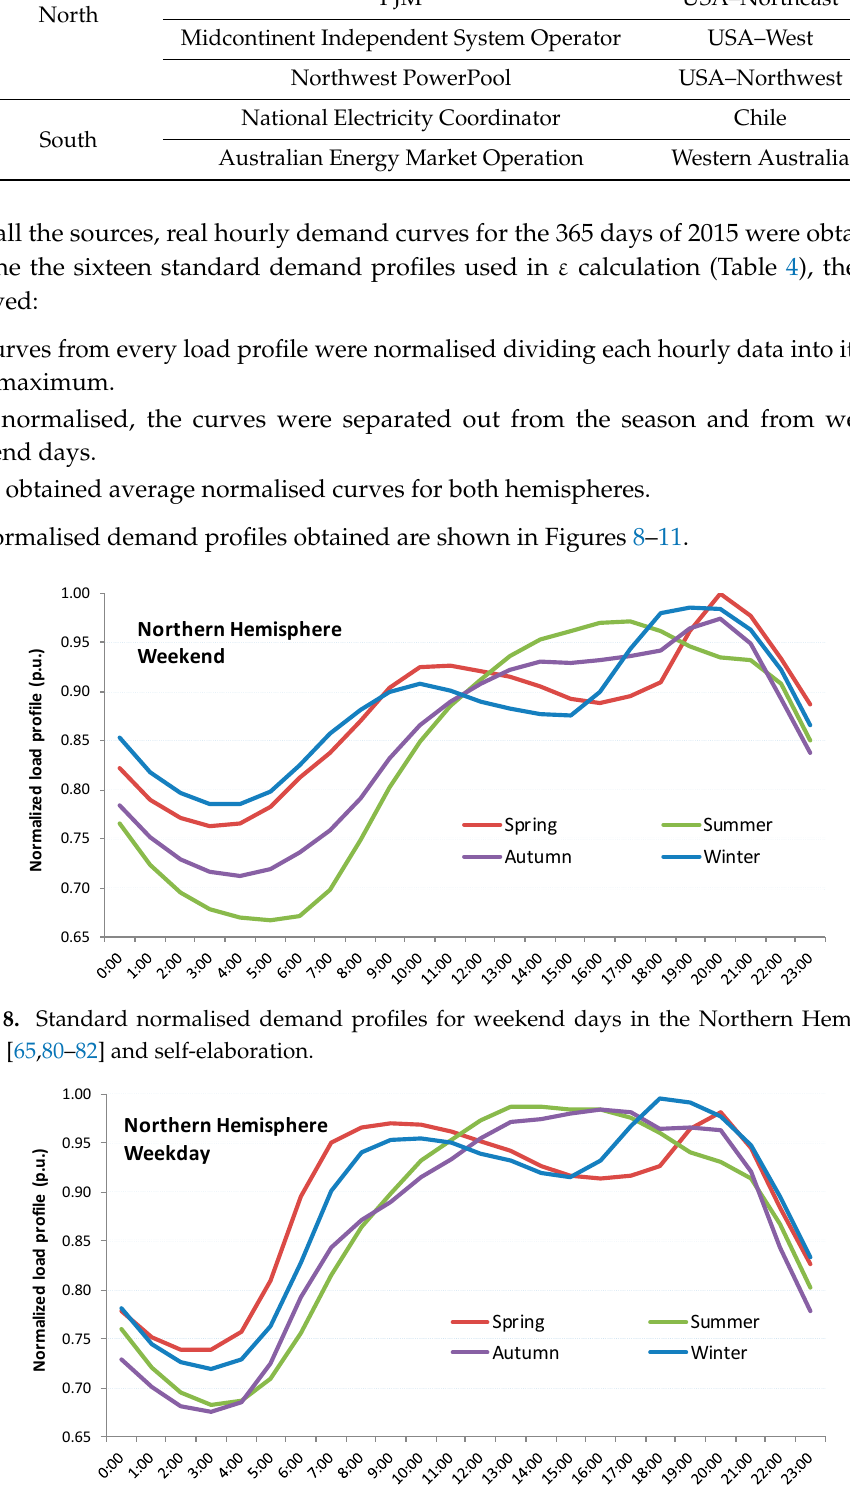
Table 7. Demand load profiles data source [65,80–84] .